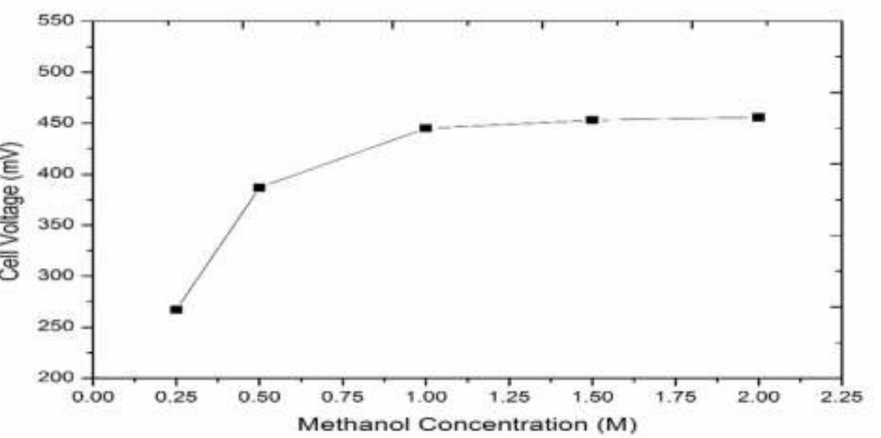
Figure 4. E ff ect of methanol